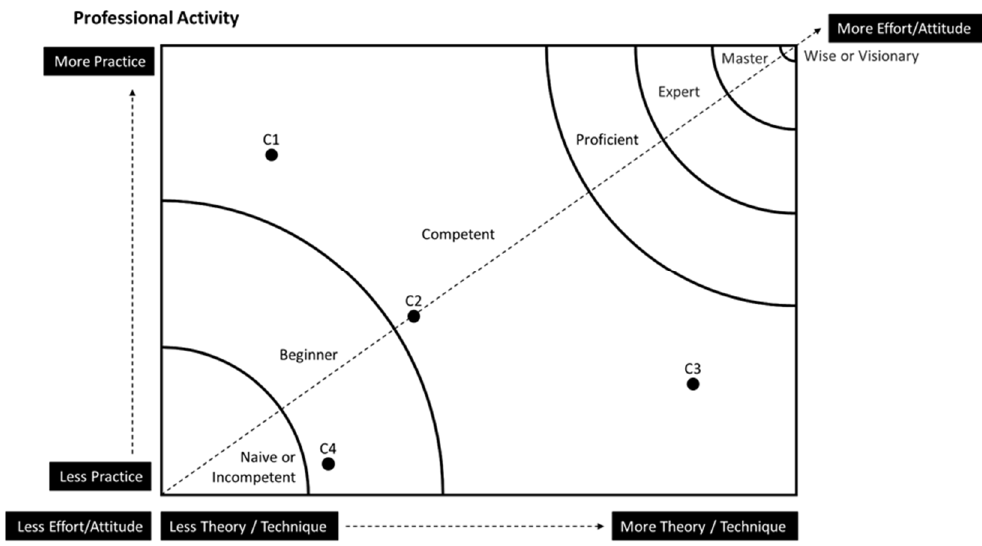
Figure 5. The evolution of skills in each professional activity.